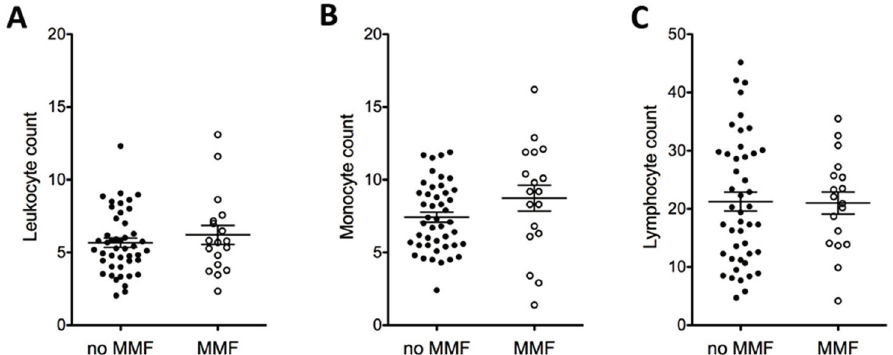
Figure 5. MMF does not directly affect full blood count. ( A ) Leukocyte, ( B ) monocyte, and ( C ) lymphocyte counts were acquired from patient records and plotted in dependency of MMF administration to SLE